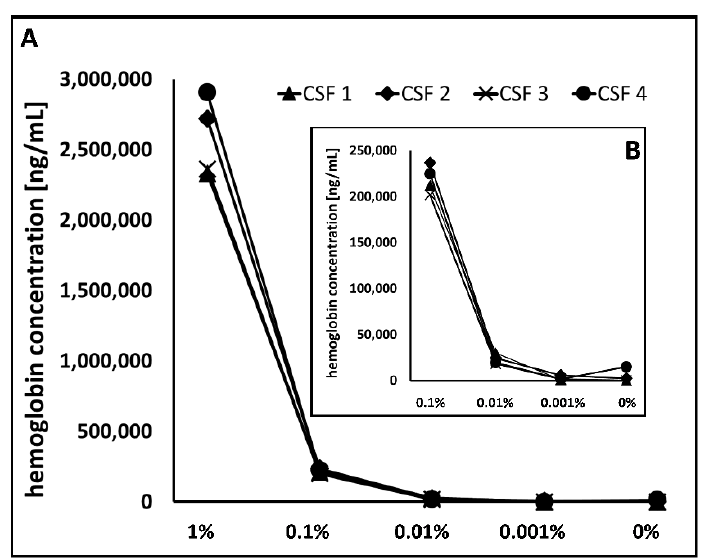
Figure 2. Blood-level-dependent hemoglobin concentration. ( A ) Hemoglobin concentration was determined in four CSF reference samples (0% blood) and corresponding artificially blood spiked samples in the range of 0.001% and 1% by ELISA. All measurements were performed in duplicate. ( B ) The magnified graph clearly demonstrates a strong increase in hemoglobin quantity starting from 0.01% spiked blood.